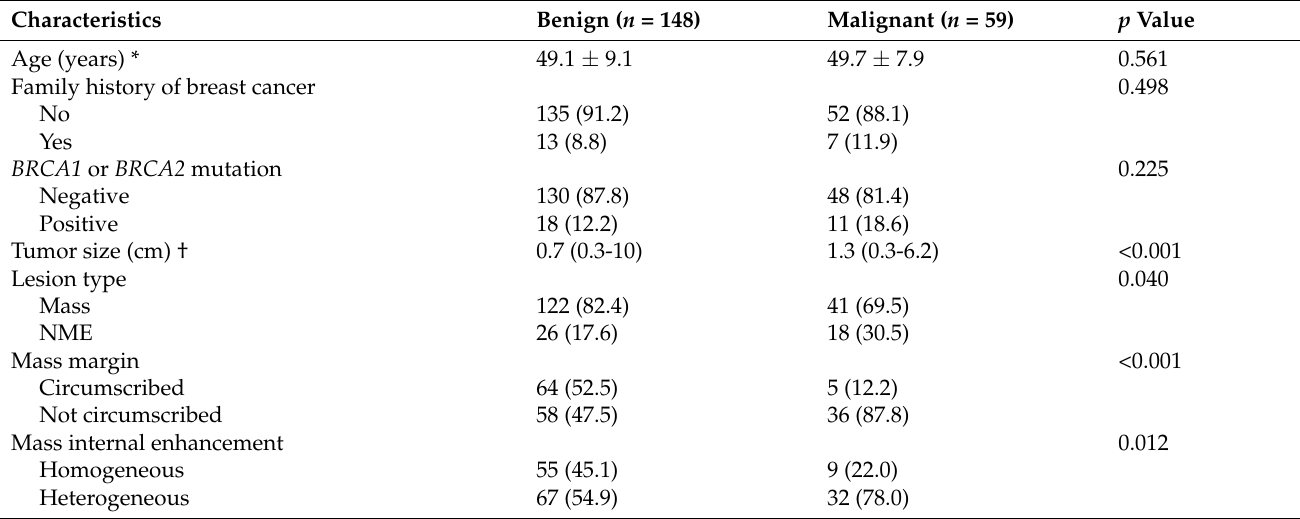
Table 1. Patient and lesion characteristics of benign and malignant